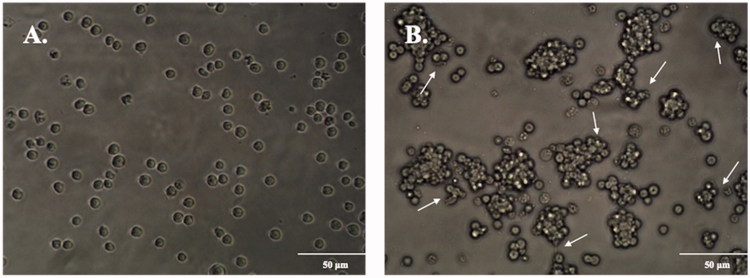
PMA induces the transition from THP-1 cells to MDMs. (A) Control cells treated with culture medium alone demonstrated a globular appearance with no cell-cell interactions. (B) Cells treated with 100 ng/mL of PMA assumed adherent morphology with apparent cell aggregation and pseudopodia (marked by arrows), representing MDMs.